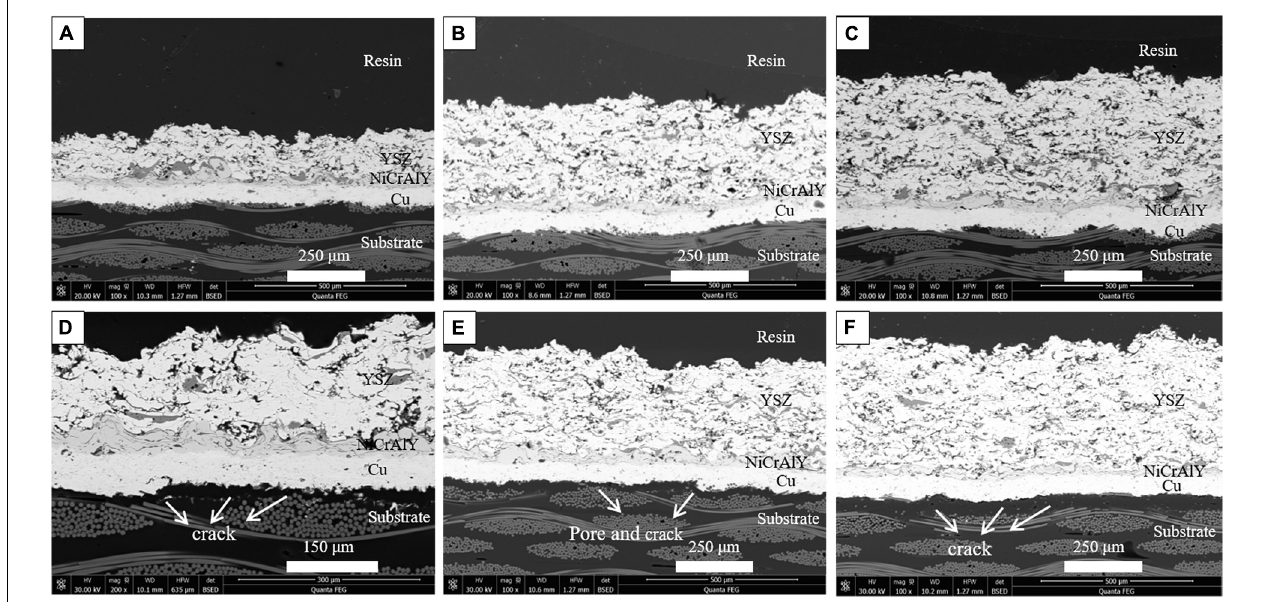
FIGURE 5 | The typical cross-sectional microstructures of coatings with different YSZ coating thickness before and after 230 ◦ C thermal shock: (A,D) 100 µ m, (B,E) 300 µ m, and (C,F) 400 µ m.